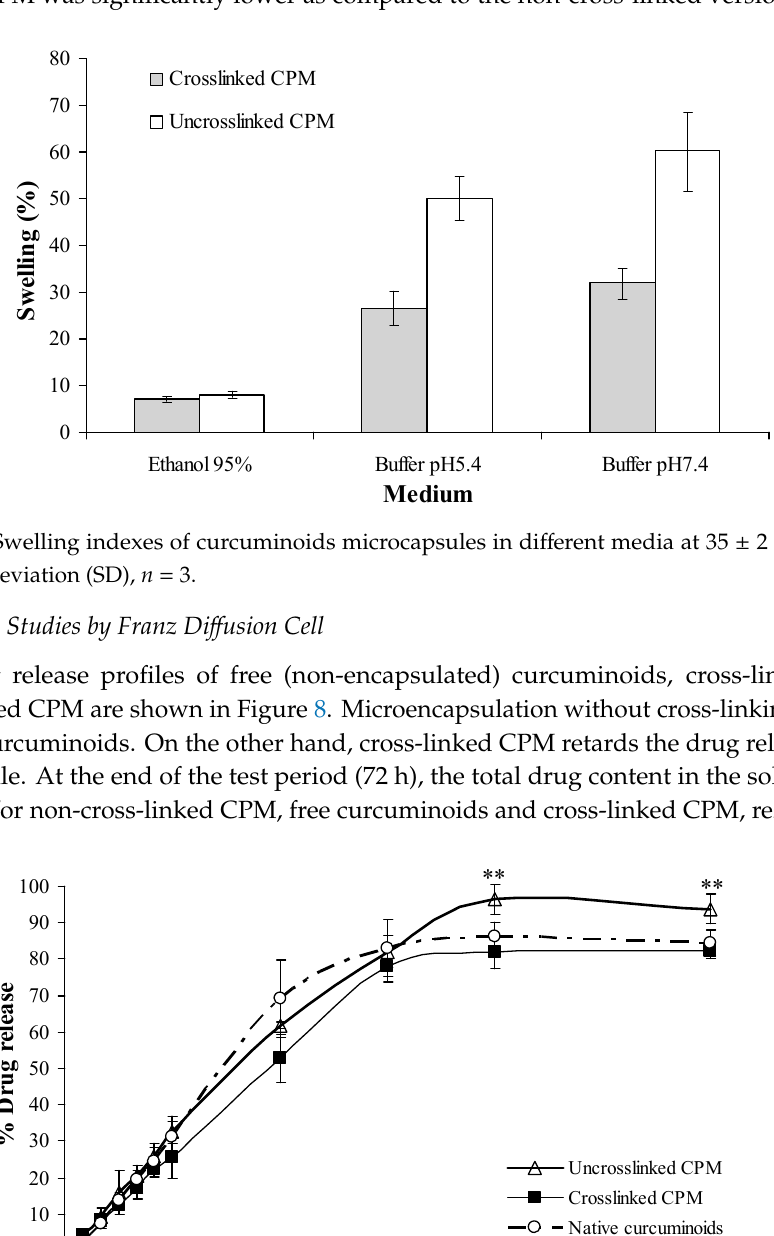
Figure 6. Fourier transform infrared ( FTIR) spectra of blank microcapsule, free curcuminoids and cross-linked CPM.